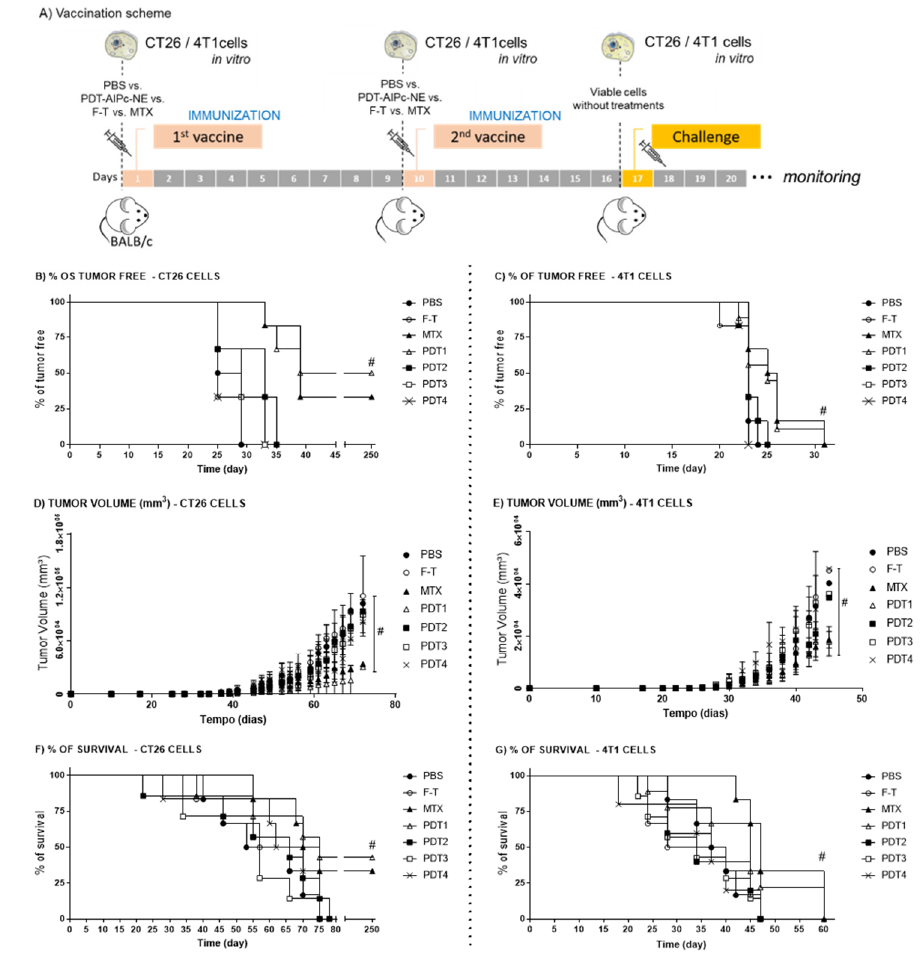
Figure 3. Assessment of the in vivo immunogenicity of cells treated with different protocols of photodynamic therapy. ( A ) Representation of the vaccination-challenge schedule using CT26 cells and 4T1 cells treated with different PDT-AlPc-NE protocols vs F-T vs MTX. CNTR represent the animal that received just PBS without cells. After the challenge the animals were monitored for: the onset of tumors ( B , C ); tumor volume ( D , E ); and survival ( F , G ) referring CT26 and 4T1, respectively. PDT protocols for CT26 cells—: PDT1 = 12.2 nM and 25 J/cm²; PDT2 = 31.5 nM and 25 J/cm²; PDT3 = 12.2 nM and 67 J/cm²; and PDT4 = 31.5 nM and 67 J/cm². PDT protocols for 4T1 cells: PDT1 = 9.01 nM and 25 J/cm²; PDT2 = 19.4 nM and 25 J/cm²; PDT3 = 9.01 nM and 67 J/cm²; and PDT4 = 19.4 nM and 67 J/cm². 1st vaccine day 0; 2nd vaccine day 10 and the challenge day 17. MTX (mitoxantrone); F-T (three cycles of freeze-thawing); PBS: phosphate buffered saline. Superscript # means p < 0.05 in comparison to control group (PBS) at the endpoint. For all data, n = 6 mice, mean ± SEM.